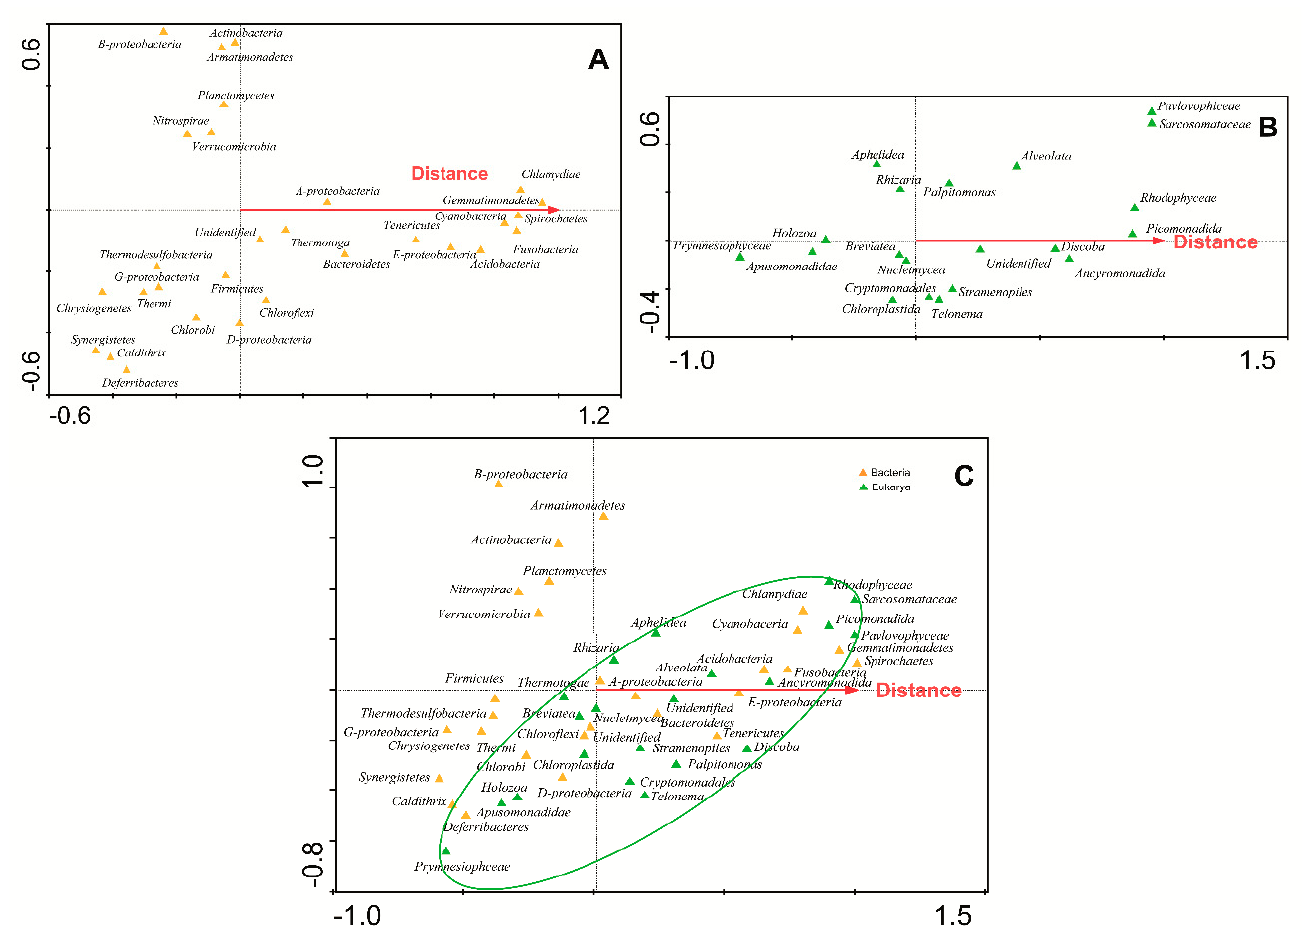
Figure 4. Canonical correspondence analysis (CCA) of the microbial phyla with respect to the distance from the volcano. CCA of phyla of bacteria ( A ) and microeukaryotes ( B ) identified in glaciers with respect to the distance from the volcano. The diagram displays triangles that represent taxonomic groups. ( C ) CCA of all the microbial phyla (bacteria and microeukaryotes) identified in glaciers with respect to the distance from the volcano. The diagram displays orange triangles for bacteria and green triangles for microeukaryotes. Venn diagram clusters an area in which microeukaryotes are more abundant.